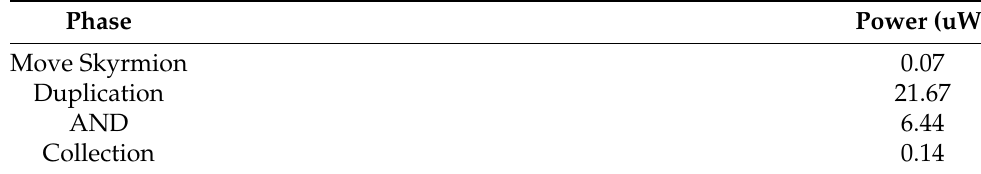
Table 3. Power consumption of a single memory cell for each phase.